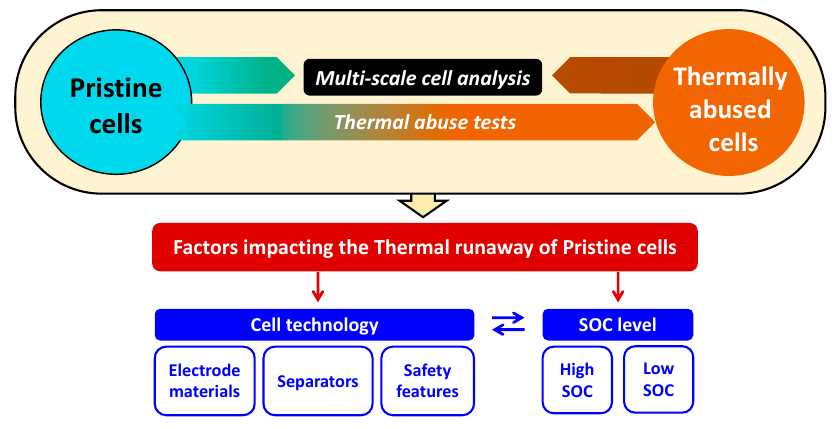
Figure 1. Research experimental methodology.